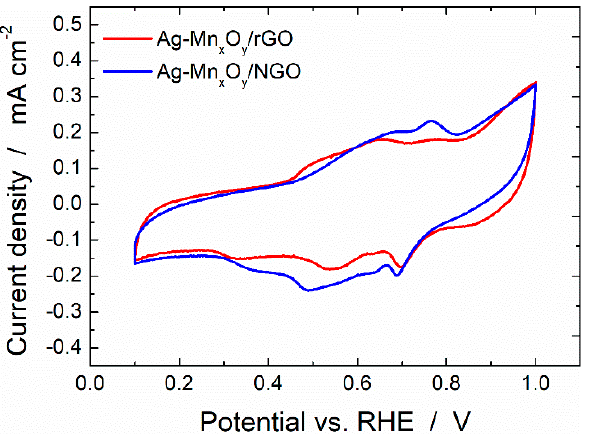
Figure 4. Base CV of Ag-Mn x O y /rGO and Ag-Mn x O y /NGO catalysts at 10 mV s − 1 in N 2 purged 1 M KOH.